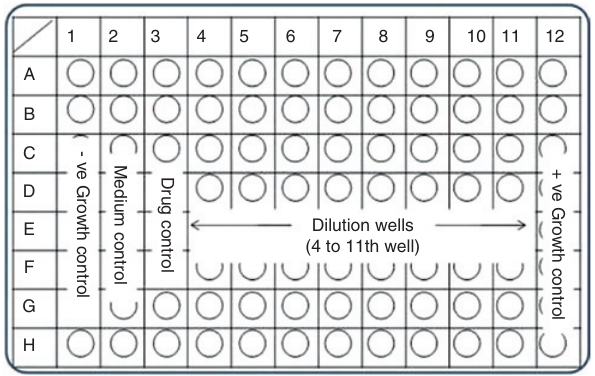
Figure 3: Ninety-six well microtiter plate with designed broth micro- dilution